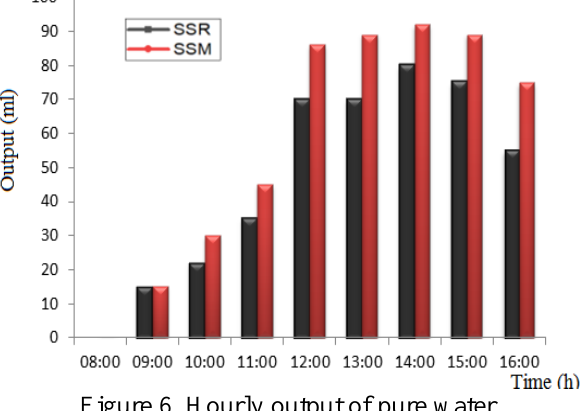
Figure 6. Hourly output of pure water